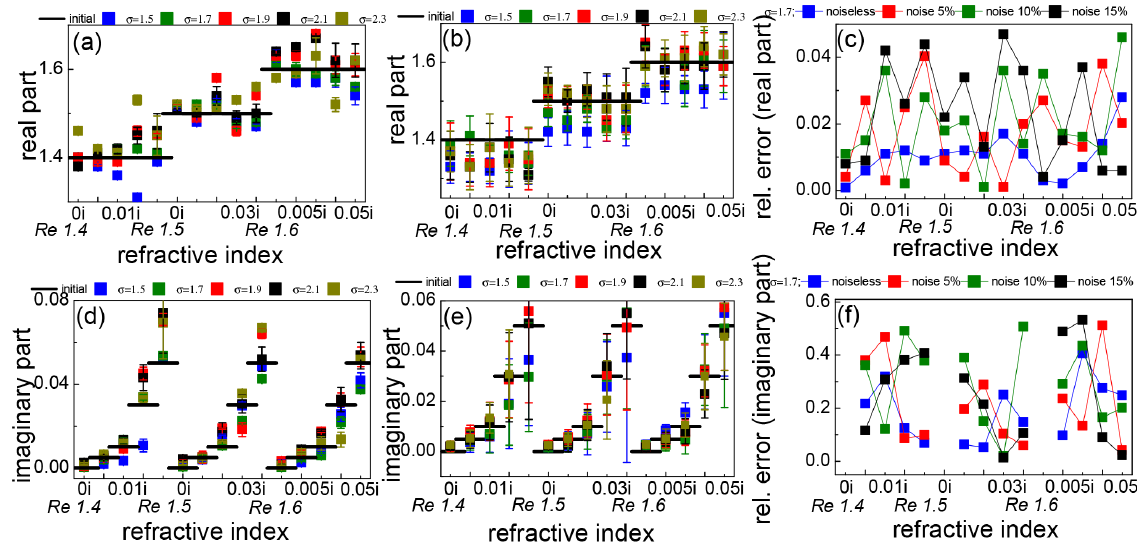
Figure 9. Retrieval results for real part of CRI (first row) and imaginary part of CRI (second row). First column corresponds to noiseless and second to 15% noisy input data. The last column shows the relative retrieval error with increasing noise level of the input data: 0, 5, 10, 15% for gsd 1.7 as an example. Each subfigure (a) – (f) is compartmentalized into three partition with respect to the horizontal axis (refractive index). The partitions correspond to different real parts of CRI namely 1.4, 1.5, and 1.6. Each partition shows the result for different imaginary parts of the CRI: 0, 0.005, 0.01, 0.03, 0.05 i . The error bars denote the standard deviation from the mean value of all selected best